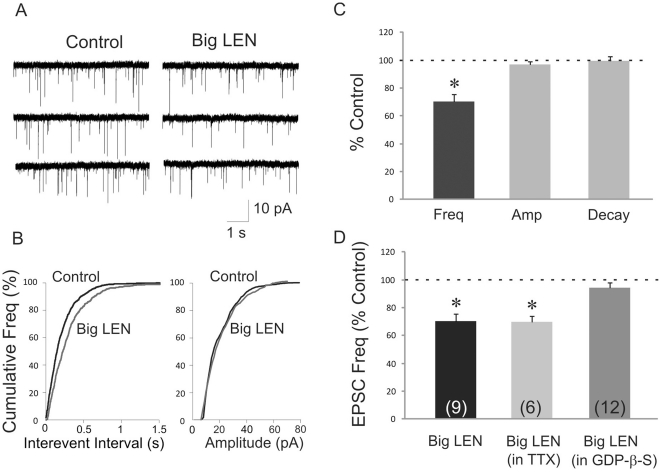
Big LEN suppresses excitatory synaptic input to PVN parvocellular neurons via the release of a retrograde messenger.A. Whole-cell patch clamp recording of spontaneous synaptic currents in a parvocellular neuroendocrine cell in the PVN in the absence (Control) and presence of big LEN (Big LEN). Big LEN (1 µM) caused a decrease in the frequency of negative synaptic currents, which are EPSCs mediated by glutamate release. B. Cumulative frequency plots of EPSC interevent intervals and EPSC amplitudes taken from the recording shown in A. Big LEN caused a shift toward longer interevent intervals, indicative of a decrease in EPSC frequency, but had no effect on the cumulative amplitude distribution. C. Mean frequency, amplitude and decay time of EPSCs in big LEN as a percentage of control measures. Big LEN (1 µM) decreased the frequency of EPSCs, but had no effect on EPSC amplitude or decay time (n = 9), suggesting a presynaptic suppression of glutamate release, but no effect on postsynaptic glutamate sensitivity. D. The effect of big LEN was maintained in TTX, indicating that the effect was action potential independent, but was blocked by an inhibitor of G protein activity (GDP-β-S) applied via the patch pipette into the postsynaptic cell, suggesting that the effect is mediated by the activation of a postsynaptic G protein-coupled receptor and release of a retrograde messenger.